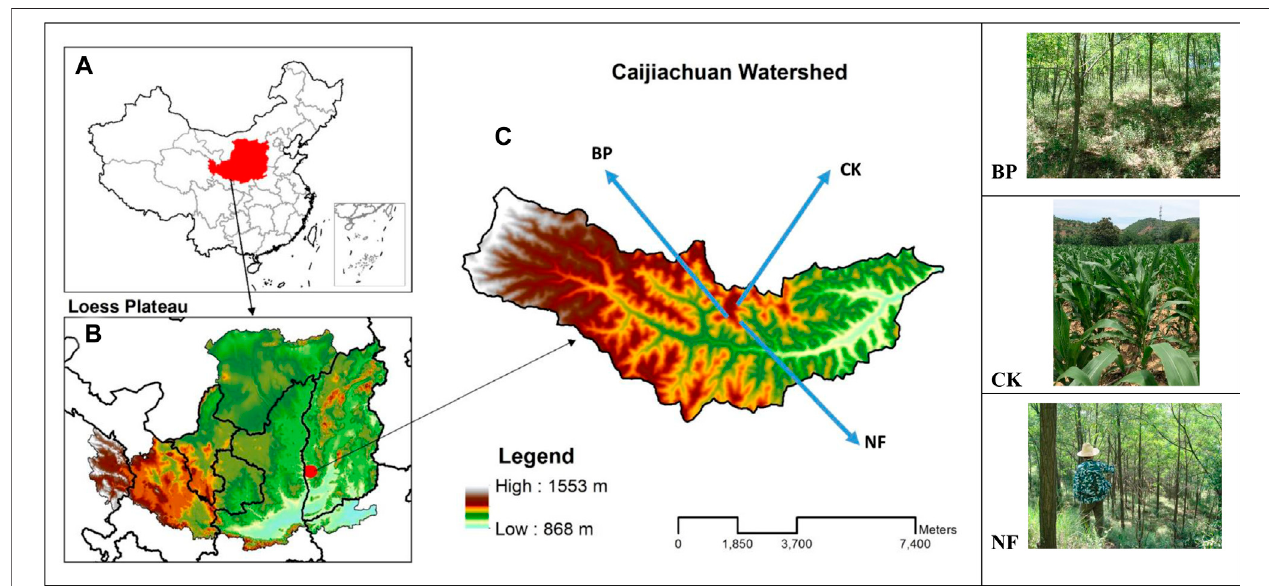
FIGURE 1 | Locations of the research sites (a: China, b: Shanxi Province, and c the Caijiachuan Watershed). NF is the naturally regenerating forest, BP is the black locust plantation, and CK is the cropland as control.